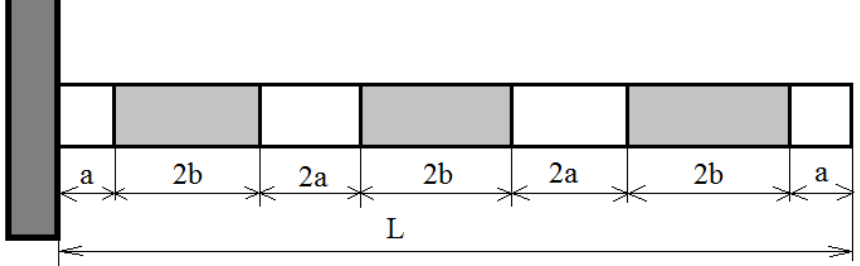
Figure A1. A one-dimensional theoretical composite.